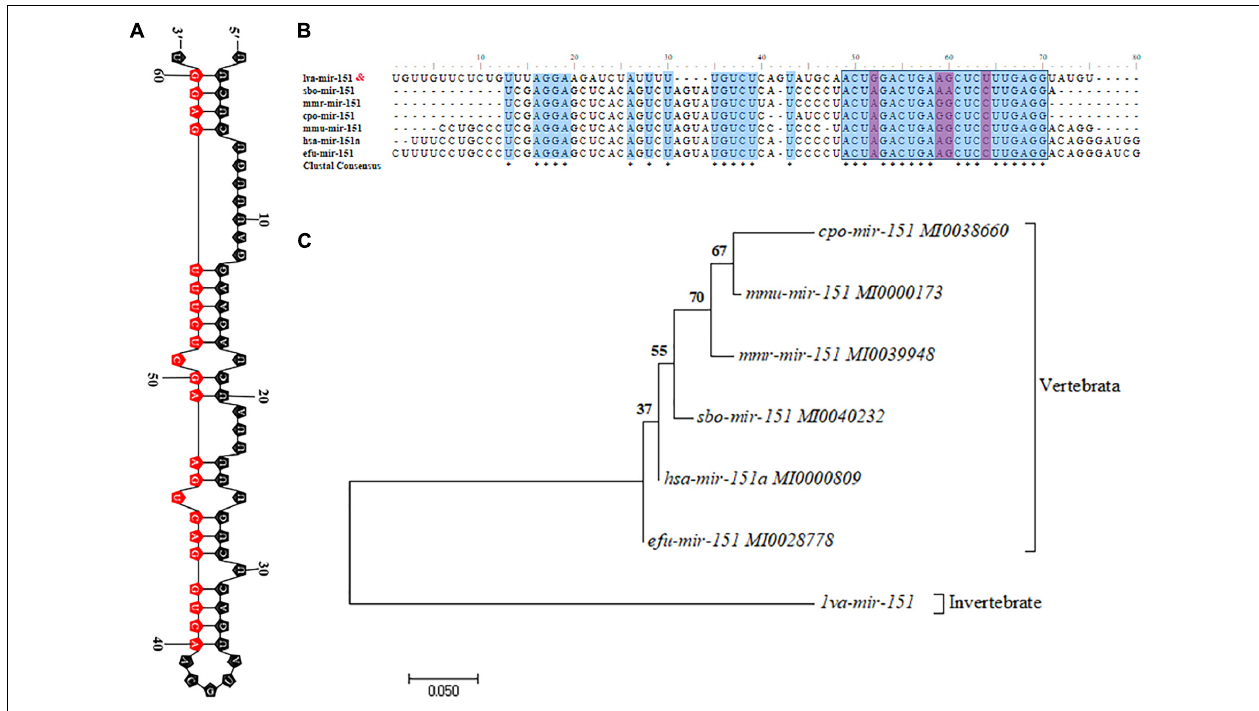
FIGURE 2 | Characteristic analysis of miR-151. (A) The hairpin structures of pre-miR-151 from Epinephelus coioides and mature miR-151 sequences are indicated in the red box. (B) Precursor miR-151 multiple sequence alignment. (C) The phylogenetic tree of precursor miR-151 with other species reconstructed by the neighbor-joining (NJ) method using the MEGA 7. The accession numbers used in this analysis are listed in the